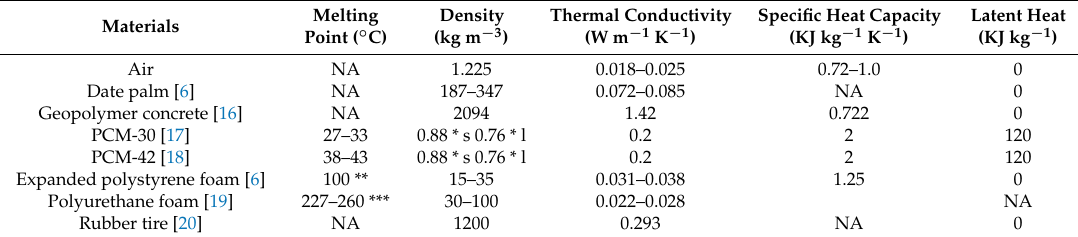
Table 1. Thermophysical properties of the investigated